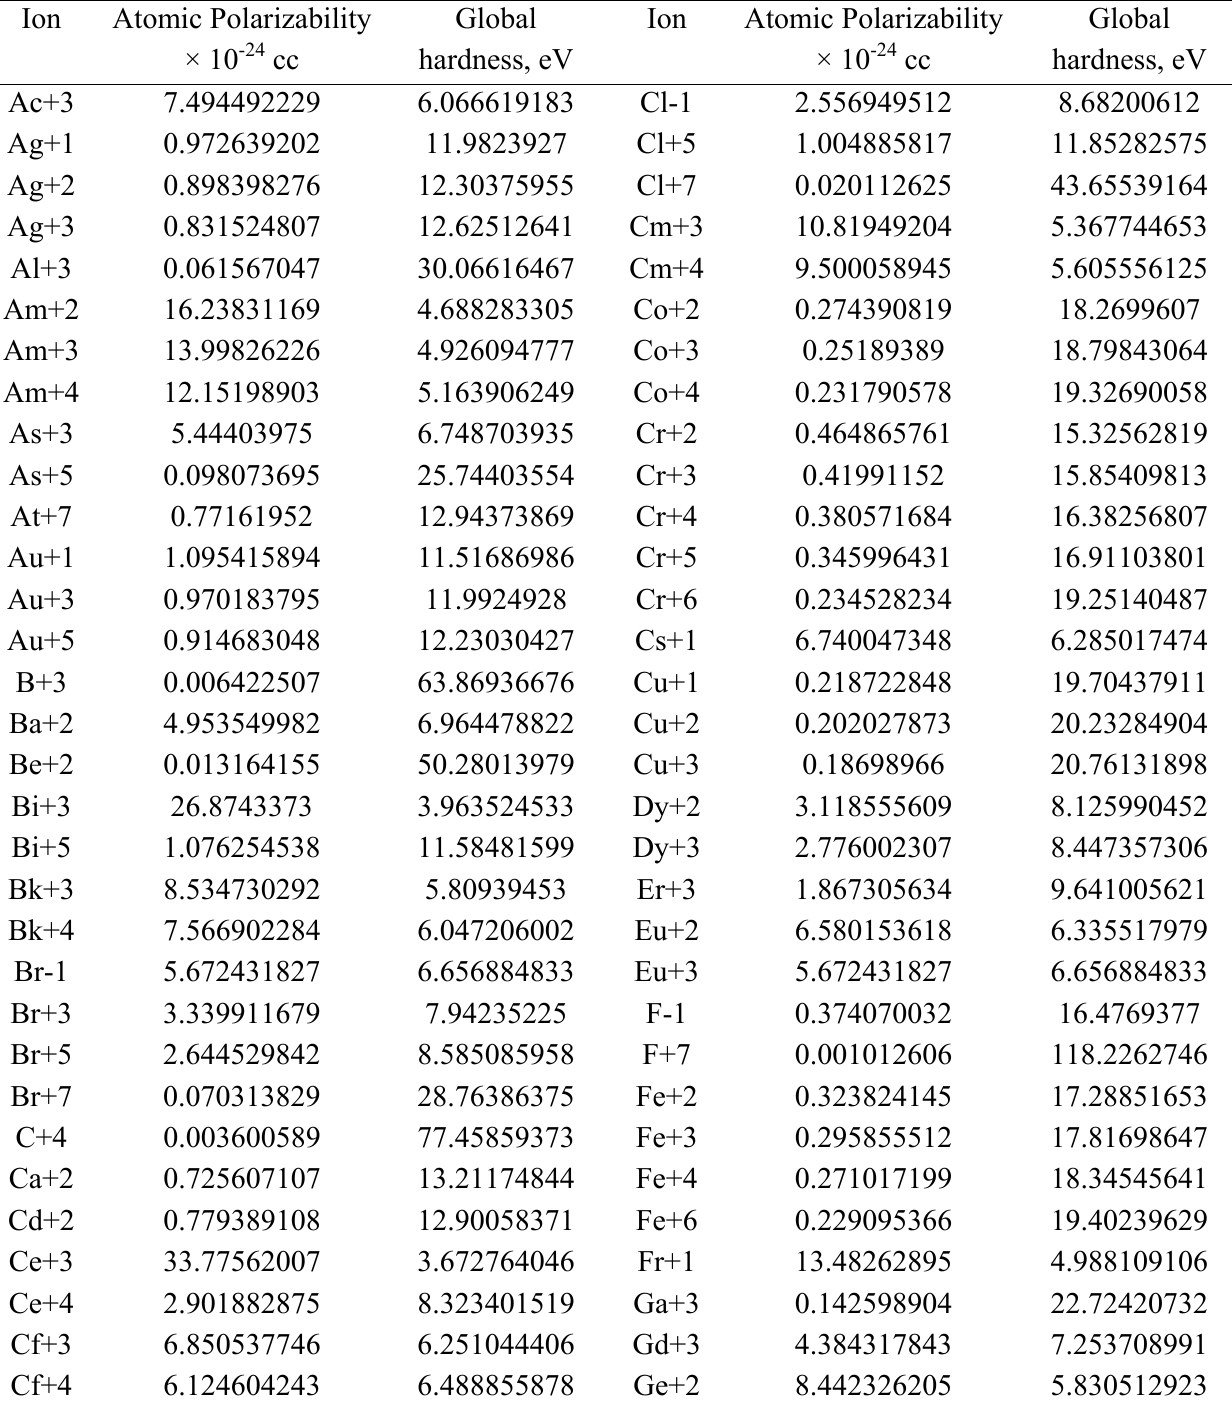
Table 3. Computed Polarizability, α , and Global hardness, η , of